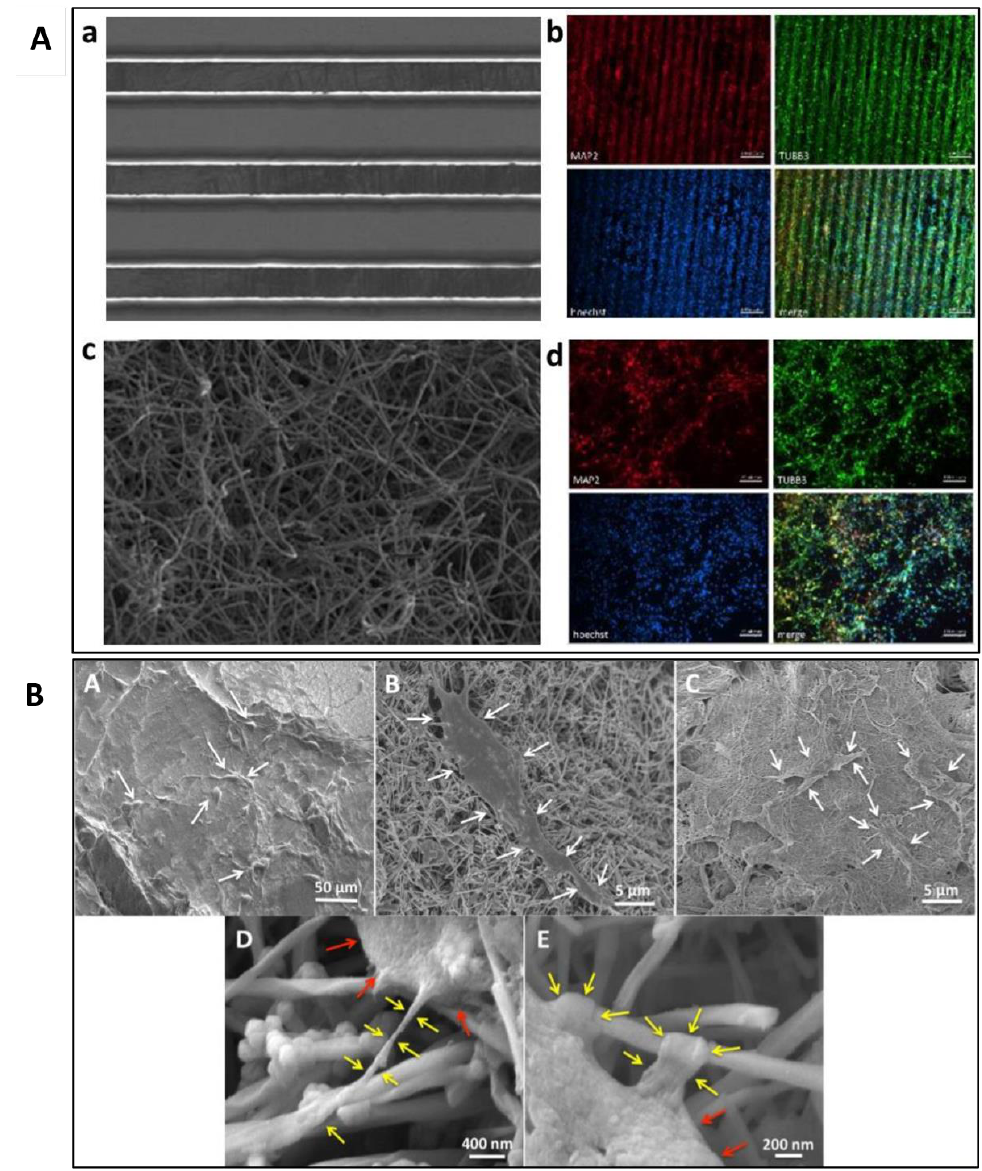
Figure 3. ( A ) SEM and fluorescent microscopy images of human NSC-derived neurons cells on Figure 3. A) SEM and fluorescent microscopy images of human NSC-derived neurons cells on pyro- lyzed aligned SU-8 ( a, b ) and PAN fibres ( c, d ). Reproduced with permission from Ref. [90]; copyright pyrolyzed aligned SU-8 (a,b) and PAN fibres (c,d). Reproduced with permission from Ref. [90]; (2020), Elsevier. B) SEM images of ADSC adhesion on ( A ) PLGA, ( B ) MWCNT, and ( C ) SWCNT copyright (2020), Elsevier. ( B ) SEM images of ADSC adhesion on (A) PLGA, (B) MWCNT, and scaffolds. Magnification images of ADSCs on MWCNT scaffolds show cytoplasmic extensions (yel- (C) SWCNT scaffolds. Magnification images of ADSCs on MWCNT scaffolds show cytoplasmic low arrows) attached to the nanotube ( D , E ). Red arrows indicate cell body. Reproduced with per- extensions (yellow arrows) attached to the nanotube (D,E). Red arrows indicate cell body. Reproduced mission from Ref. [98]; copyright (2017), John Wiley and Sons. with permission from Ref. [98]; copyright (2017), John Wiley and